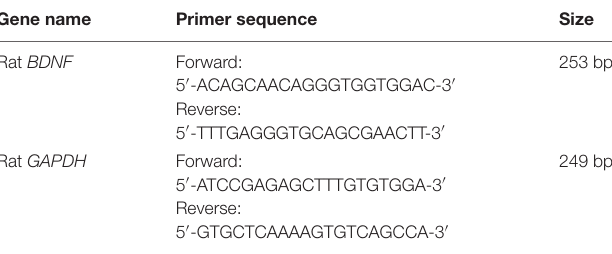
TABLE 3 | Primer sequences of RT-PCR